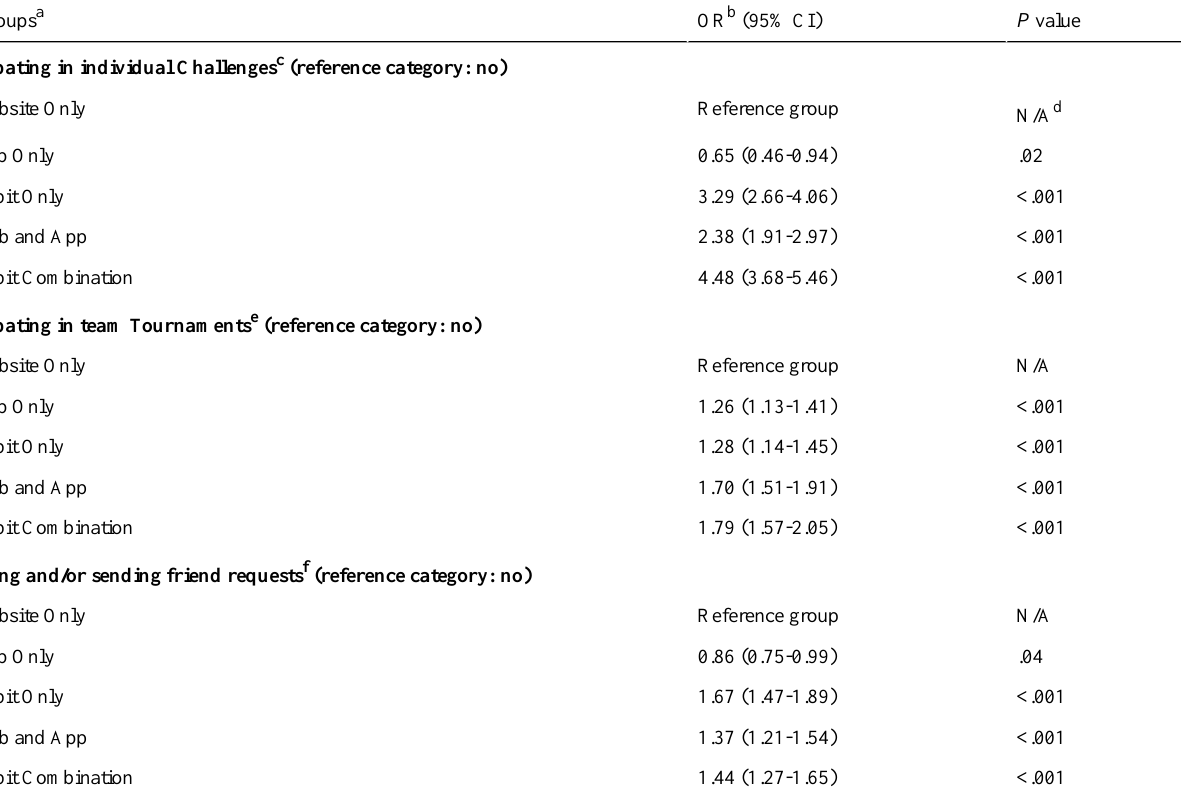
Table 3. Associations between participating in Challenges and Tournaments and receiving and sending friend requests from January 1 to December 31, 2018 among the 10,000 Step user